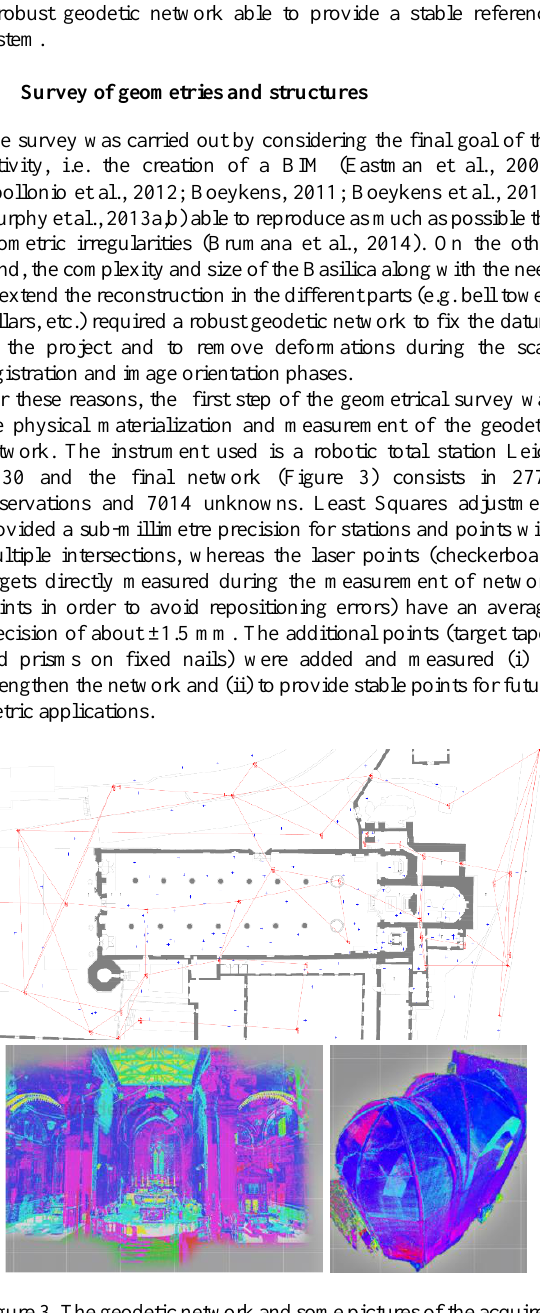
Figure 3. The geodetic network and some pictures of the acquired laser scans.